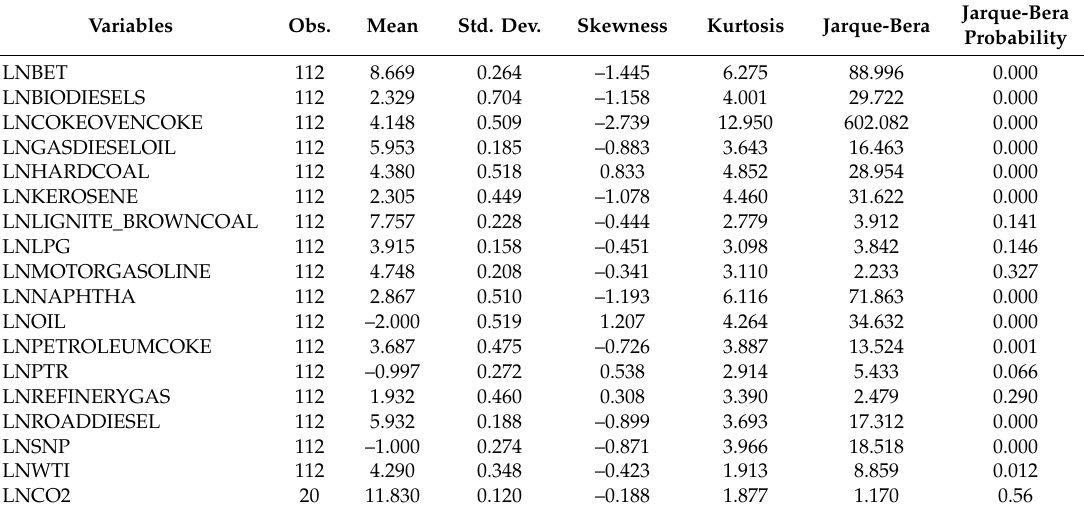
Table 3. Descriptive statistics of the